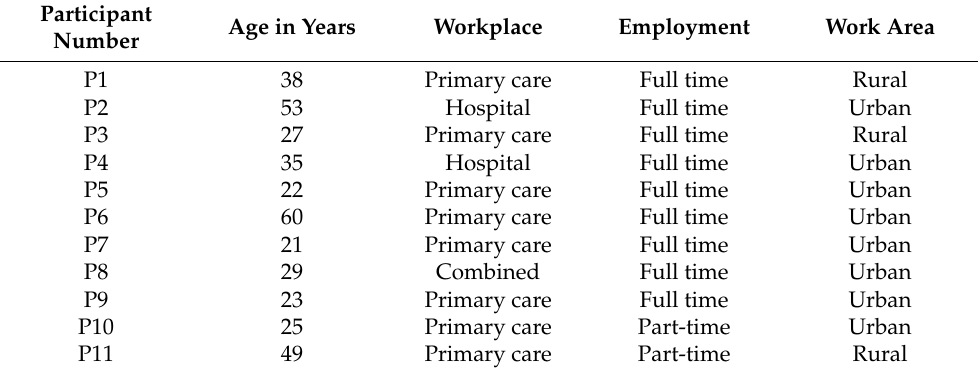
Table 1. Characteristics of